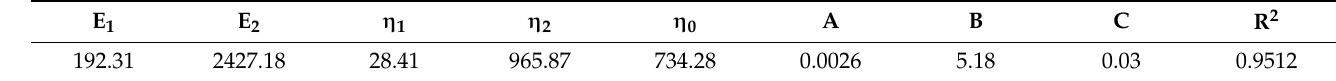
Table 4. Creep parameters under the fifth stress grade.